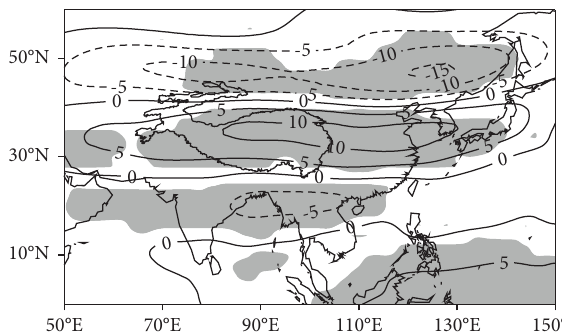
Figure 5: Diference synthetic feld of 200hPa zonal wind of strong AHS/weak westerly-monsoon year and weak AHS/strong westerly- monsoon year (shadow indicates passing 95% reliability test, unit: